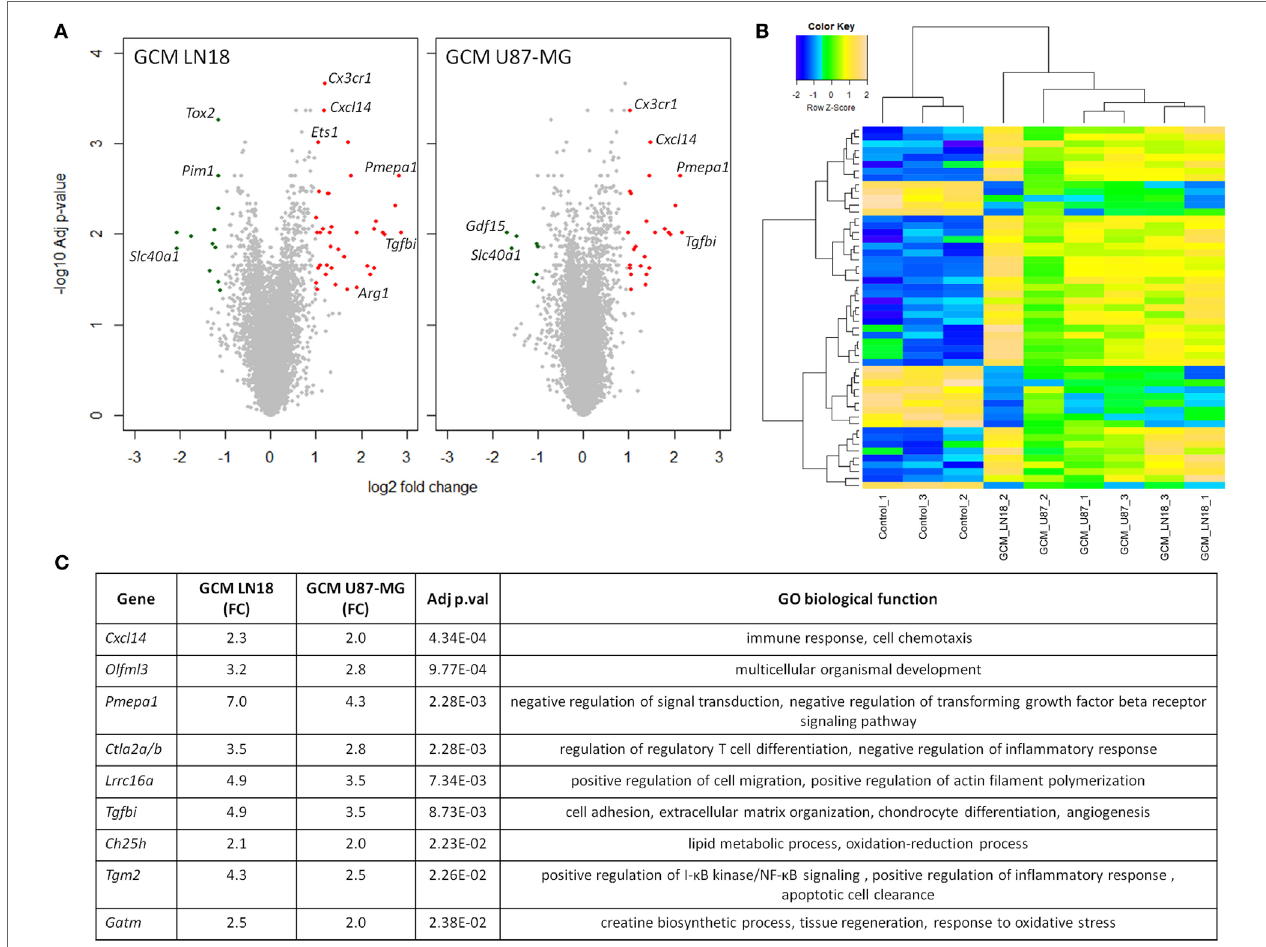
FigUre 4 | Global gene analysis in primary microglia cultures stimulated with glioma-conditioned medium (GCM) from human glioma cells. Primary microglia cultures were treated for 6 h with GCM. Total RNAs were isolated and subjected to Affymetrix microarray analysis. Data were pre-processed as described in Section “Materials and Methods” and significantly regulated genes are depicted. (a) Volcano plots represent log2 fold change versus − log10 adjusted p -value in microglia treated with GCM from LN18 and U87-MG glioma cells; upregulated genes are marked in red; downregulated genes in green. (B) Heatmap was generated to show significantly differentially expressed genes and sample clustering. (c) Selected top significantly upregulated genes in microglia treated with GCM LN18 or U87-MG were listed in a table with fold change expression (FC), adjusted p -value, and associated Gene Ontology (GO) biological functions. Significance was assigned to adj p -val <